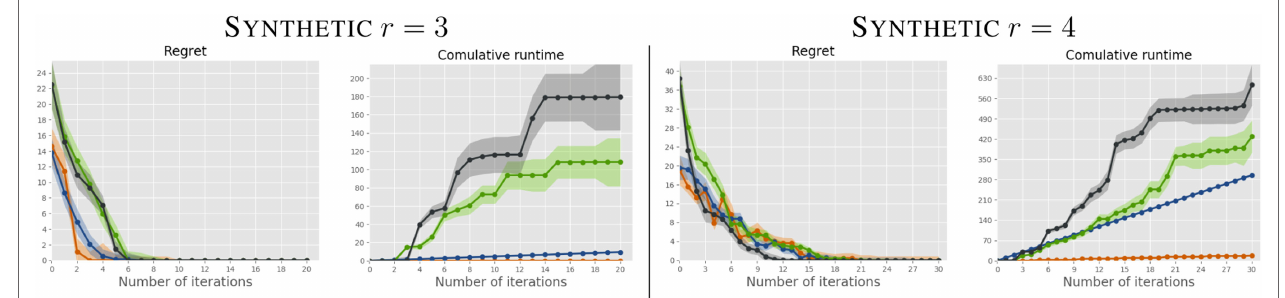
FIGURE 2 | Comparison between SM (orange), VOI (blue),  (green), and  (gray) on the r = 3 (left) and r = 4 (right) synthetic problems on users with dense preferences. Best viewed in color.